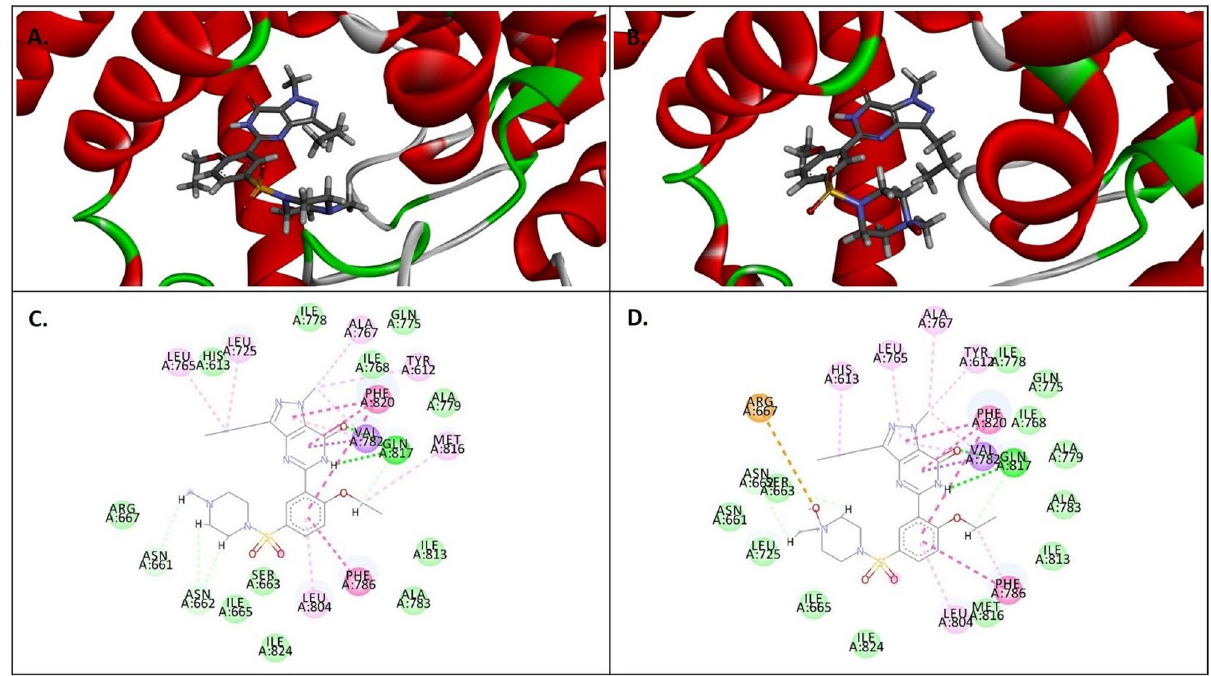
Figure 11. Binding interaction of ligands within the catalytic site of PDE5 enzyme. 3D interaction of ( A ) SLD, ( B ) SLD N-oxide, and 2D interaction of ( C ) SLD, (D) SLD N-oxide. The type of interactions is represented in Discovery studio visualizer by color codes in which hydrogen bond, van der Waals, attractive charges, Pi-Pi, and Pi-Alkyl interactions are depicted in dark green, light green, brown, dark pink, and light pink colours